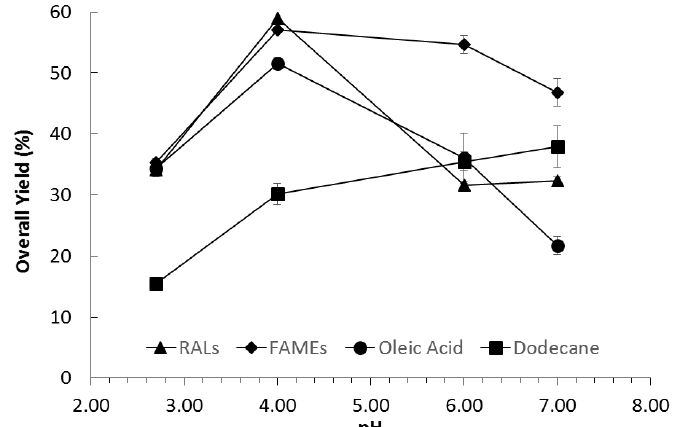
Figure 4. Overall yield as a function of pH for RALs, FAMEs, oleic acid, and dodecane collectors at a fixed dosage of 2.79 kg/t.